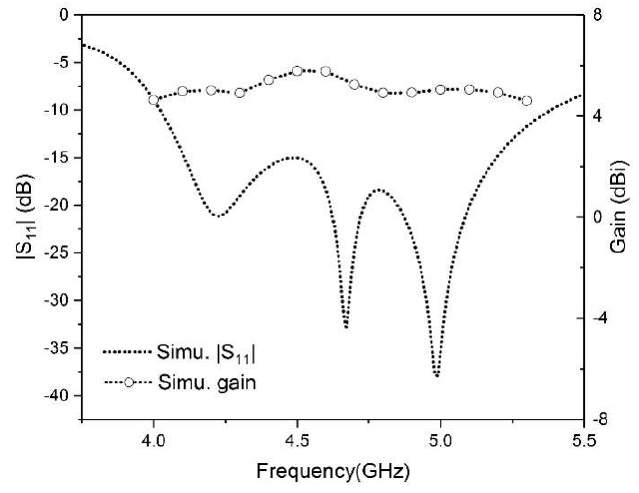
Figure 2. Simulated | S 11 | and gain of the proposed MTM-based wideband antenna element. Table 1. Parameter values of the wideband antenna shown in Figure 1 (unit: mm).